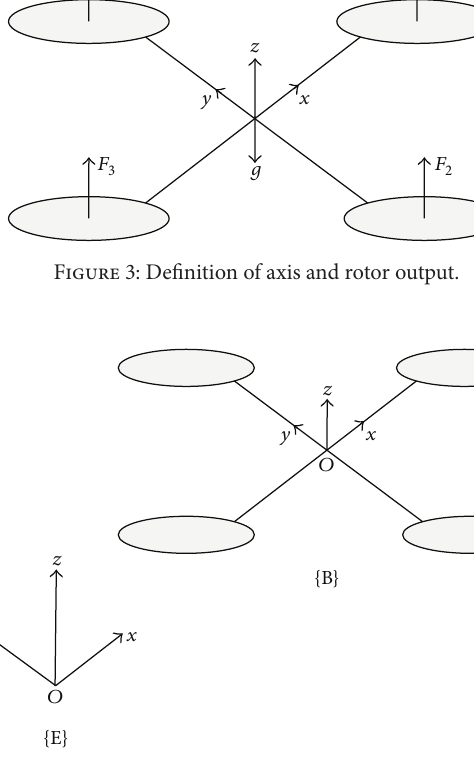
Figure 4: Model of the structure of the